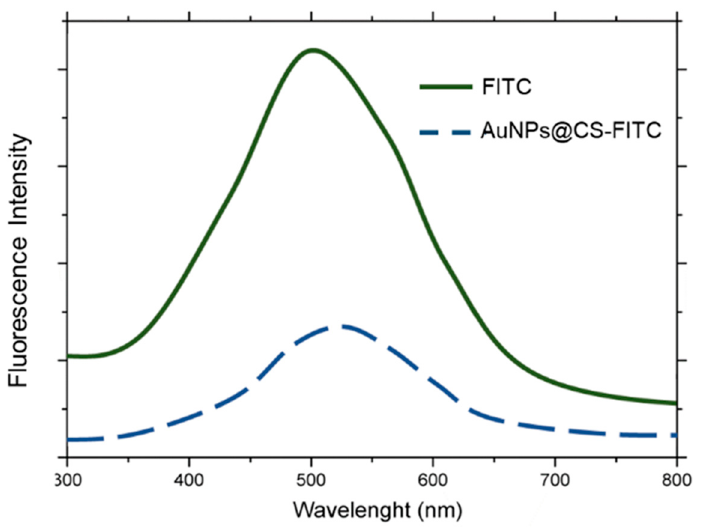
Figure 5. Emission spectra ( λ ex = 488 nm) of FITC and AuNPs@CS-FITC.